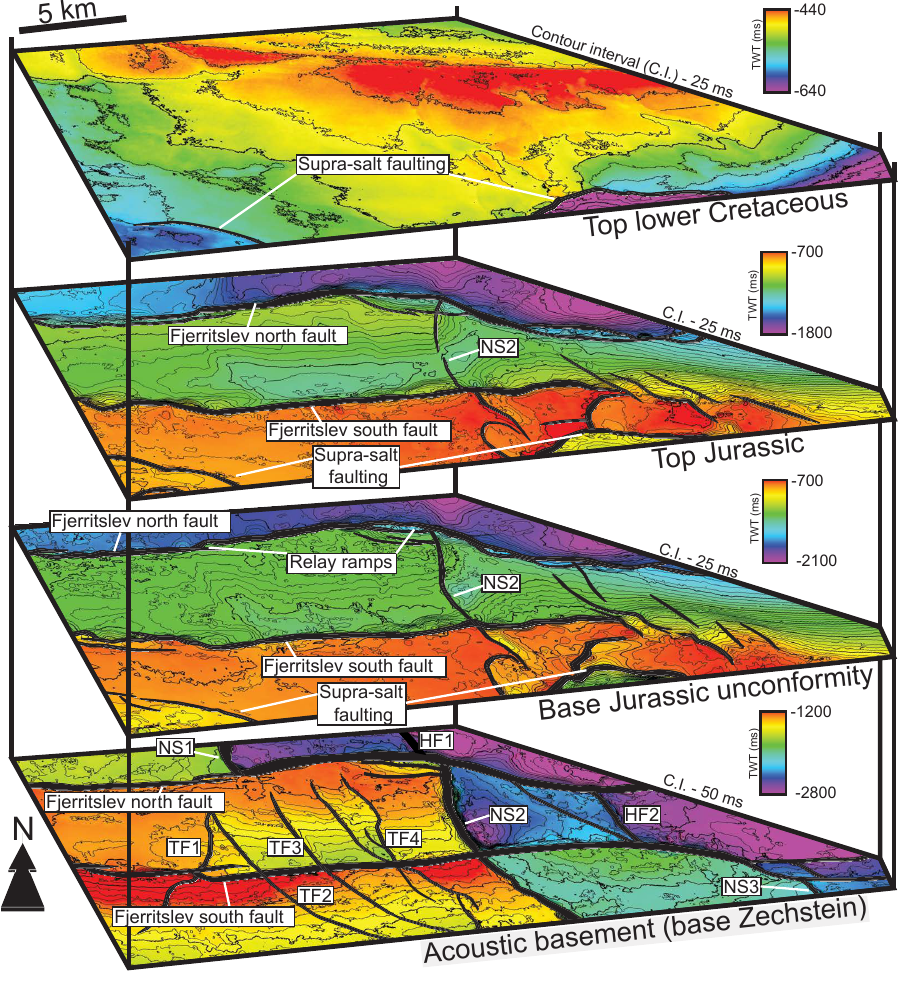
Figure 3. Two-way time structure maps of the key stratigraphic horizons used within this study, as mapped within the 3-D seismic volume. The acoustic basement (base Upper Permian Zechstein salt), base Jurassic unconformity, top Jurassic, and top Lower Cretaceous surfaces are shown. Vertical separation not to scale. See Fig. 1c for location of the 3-D seismic